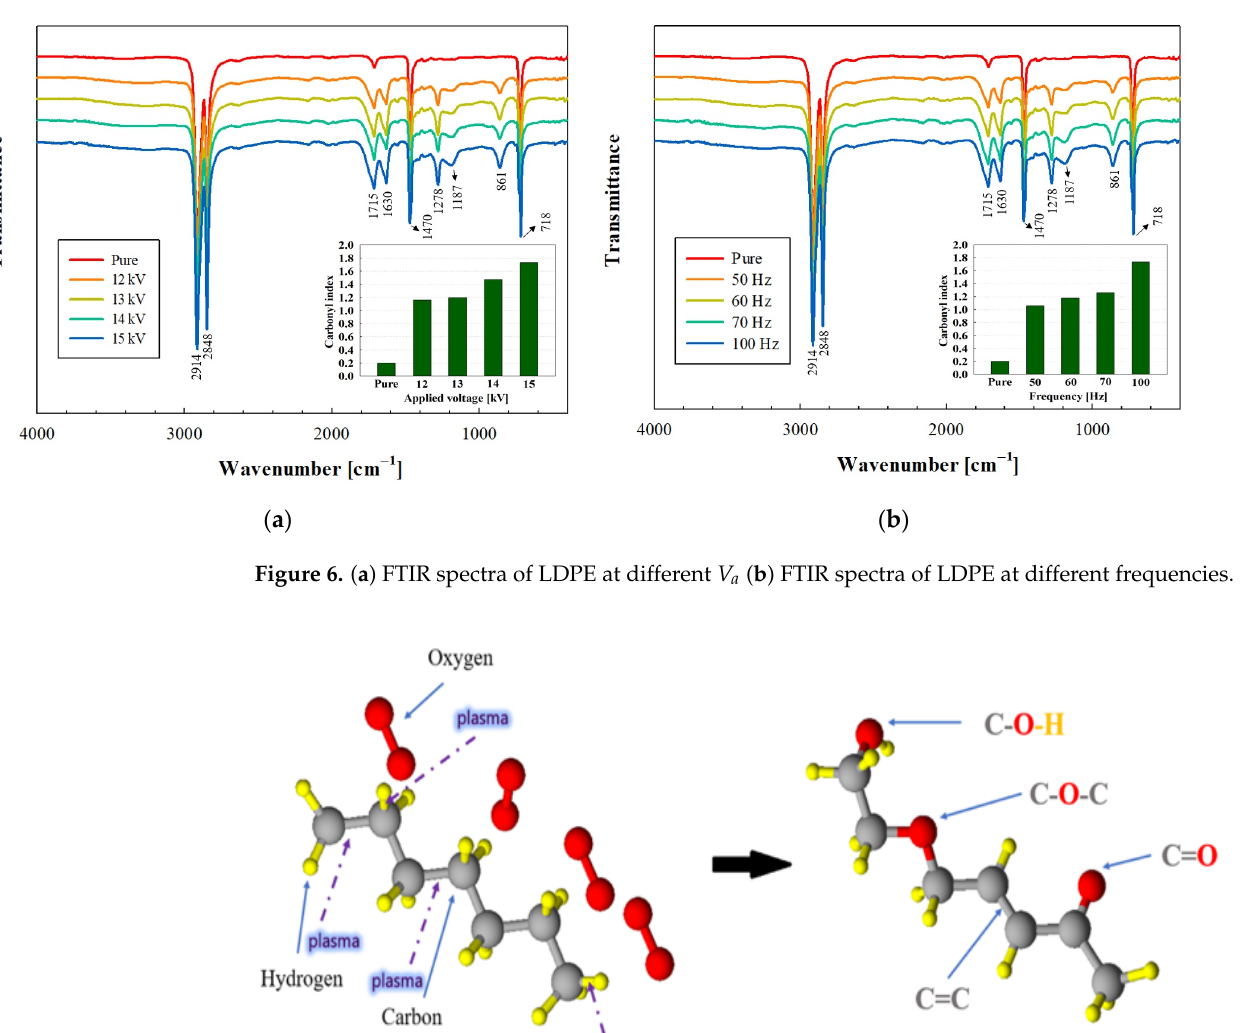
Figure 7. Chemical bonds changed during plasma treatment.